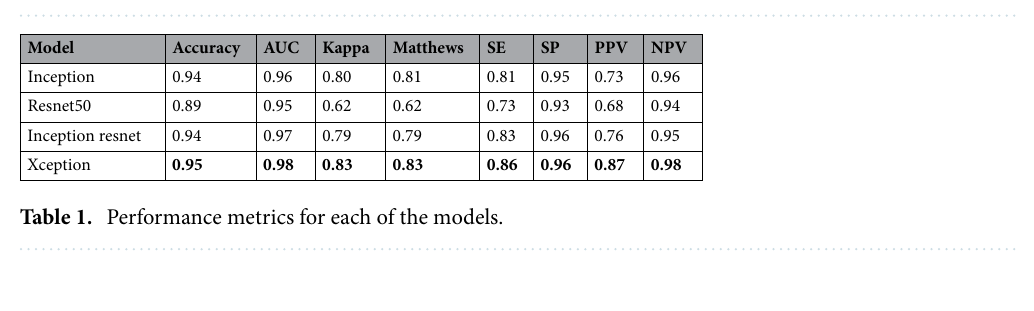
Figure 1. ROC curves for the models grouped by Class. ( a ) Class 0, ( b ) Class 1, ( c ) Class 2, ( d ) Class 3, ( e ) Class 4.